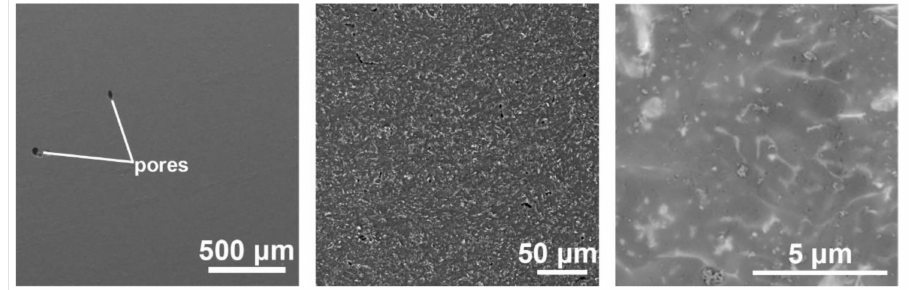
Figure 5. Microstructure of the 3D-printed material at different